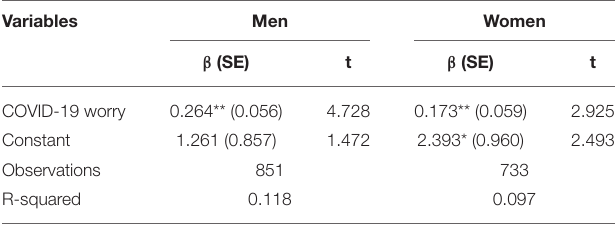
TABLE 4 | Effect of COVID-19 worry on mental health, by gender.